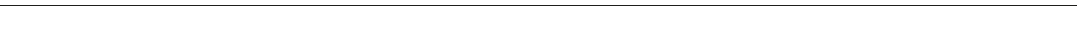
Fig. 1 CKAMP44 modulates gating and amplitude of AMPAR-mediated currents in dLGN neurons. a , b CKAMP44 in situ hybridization analysis with an oligoprobe ( a ) and riboprobe ( b ) on horizontal brain sections of P14 and adult mice respectively a : n = 3, b : n = 6). The higher magni fi cation in b shows the comparable CKAMP44 mRNA signal intensity in dLGN neurons and dentate gyrus granule cells. c , d The AMPA/NMDA ratio is reduced in retinogeniculate (RG; c , n = 19 for relay neurons of wildtype and 19 for relay neurons of CKAMP44 − / − mice) and corticogeniculate (CG; d n = 15 for relay neurons of wildtype and 18 for relay neurons of CKAMP44 − / − mice) synapses of CKAMP44 − / − mice (Box-and-whisker Tukey plots with median, IQR and 1.5 times the IQR, Mann – Whitney test). A schematic representation of RG and CG synapse activation with localization of stimulation pipettes is shown on